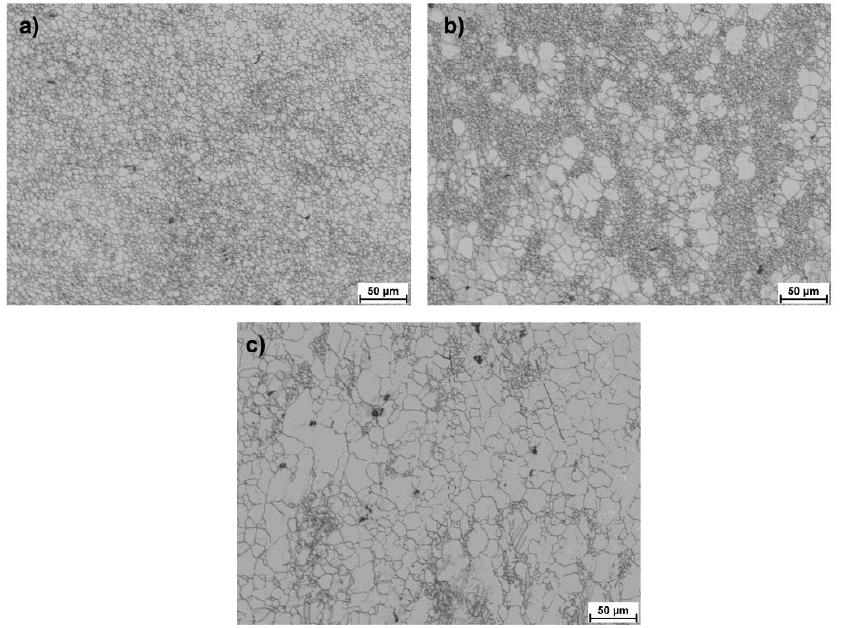
Figure 10. Microstructure obtained for finished bars with the diameter of 15 mm rolled according to Variant I, defined for ( a ) surface zone, ( b ) middle zone, ( c ) central zone.